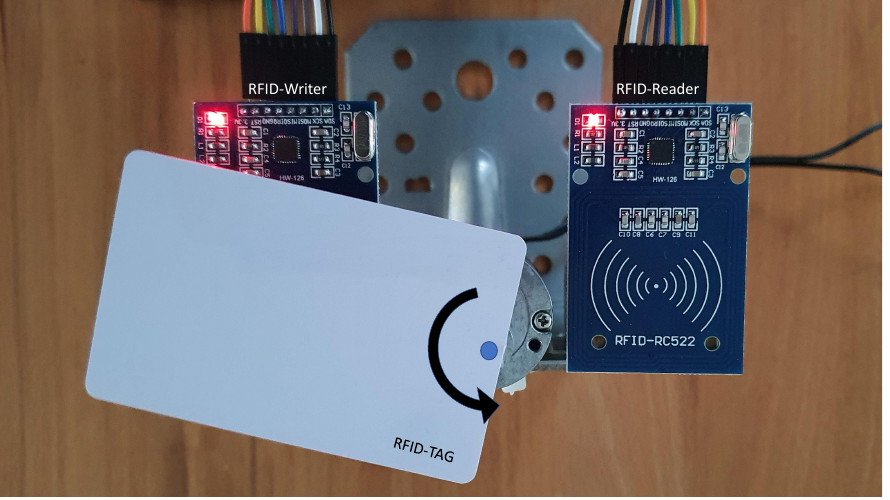
Figure 3. RFID data collection.